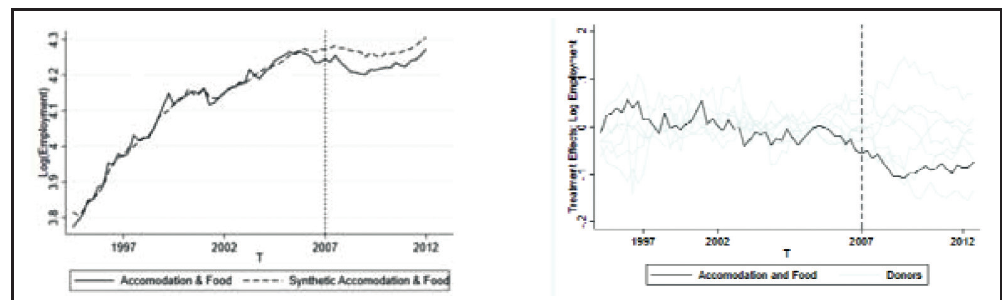
Figure 9 Treatment Effects and Placebo Test: Accommodation and Food Industry (Island Industry